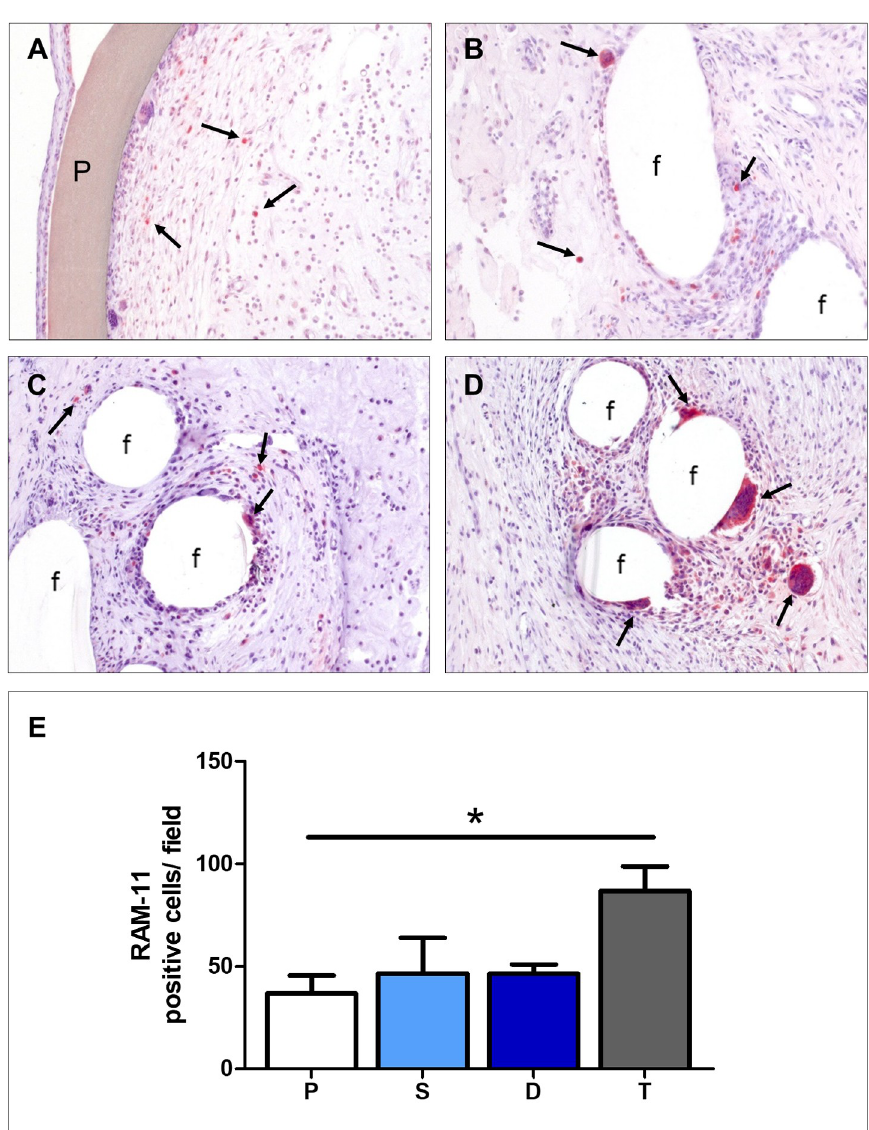
(A) Preclude, (B) Surgipro, (C) DynaMesh and (D) TiMESH. f: mesh filaments, P: Preclude. (E) Positive cell counts per field recorded after 14 days of implantation. The results are shown as the means ± standard error of the mean for the different study groups: P (Preclude), S (Surgipro), D (DynaMesh) and T (TiMESH). � p < 0.05.